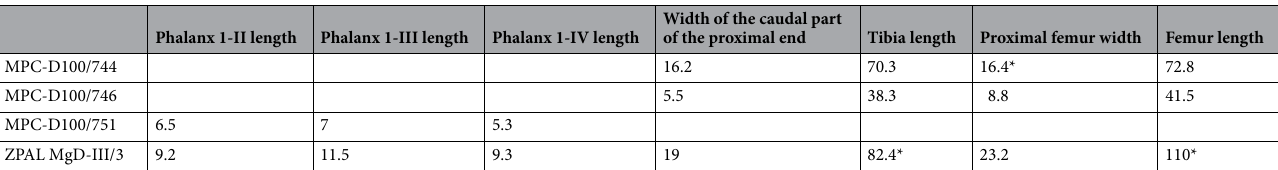
Table 1. Measurements (in cm) of ZPAL MgD-III/3 in comparison to the largest representatives of Gobihadros mongoliensis reported by Tsogtbaatar et al. 17 . Asterisks indicate lengths estimated from proportions due to the incompleteness of the specimens.